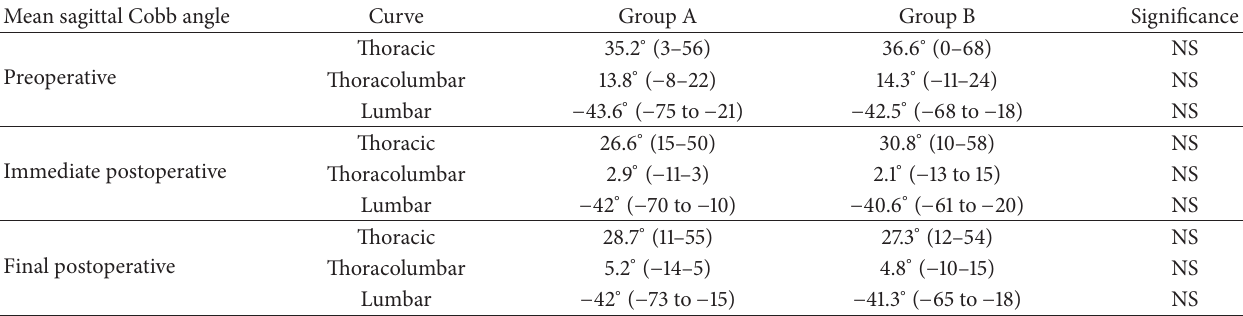
Table 2: Sagittal preoperative, immediate, and final postoperative Cobb angle measurements in both